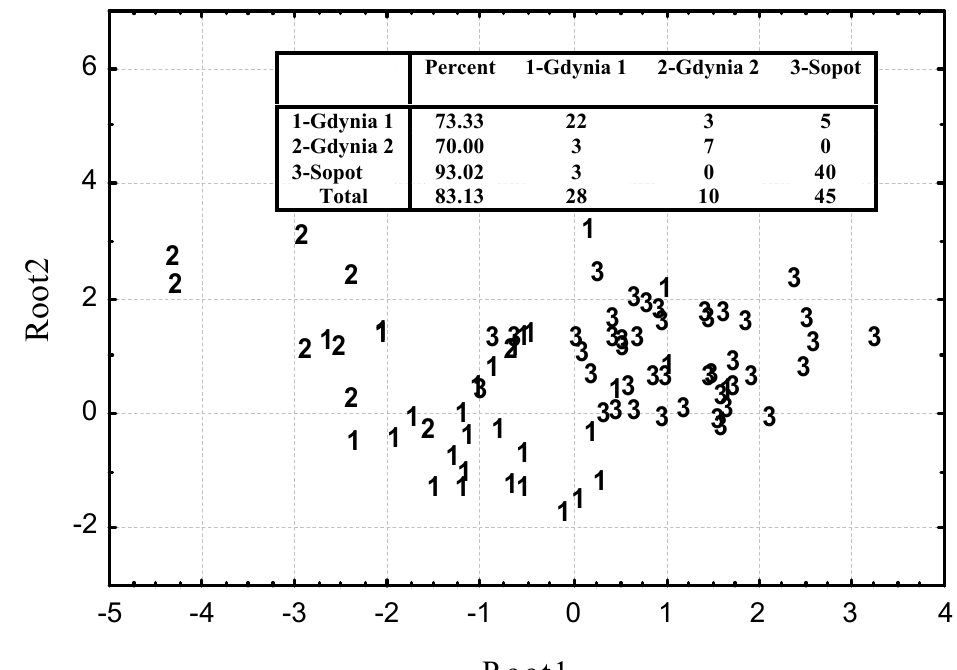
Figure 2. Scatterplot of canonical scores on the plan described by root 1 and root 2 (Gdynia 1, Gdynia 2 and